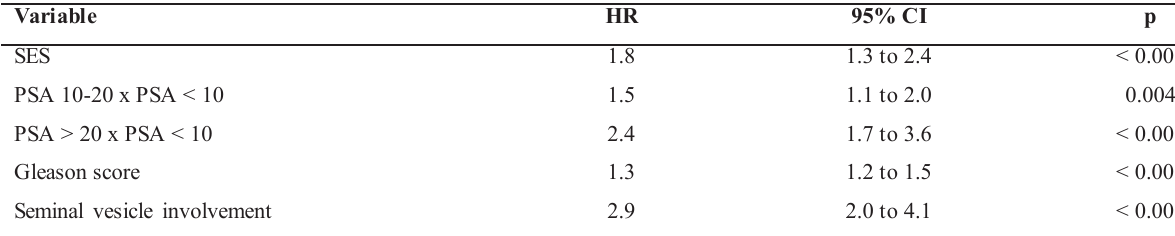
Table 2 - Postoperative Result Assessment Criteria. Table 2 - Multivariate cox regression analysis for the risk of disease recurrence.